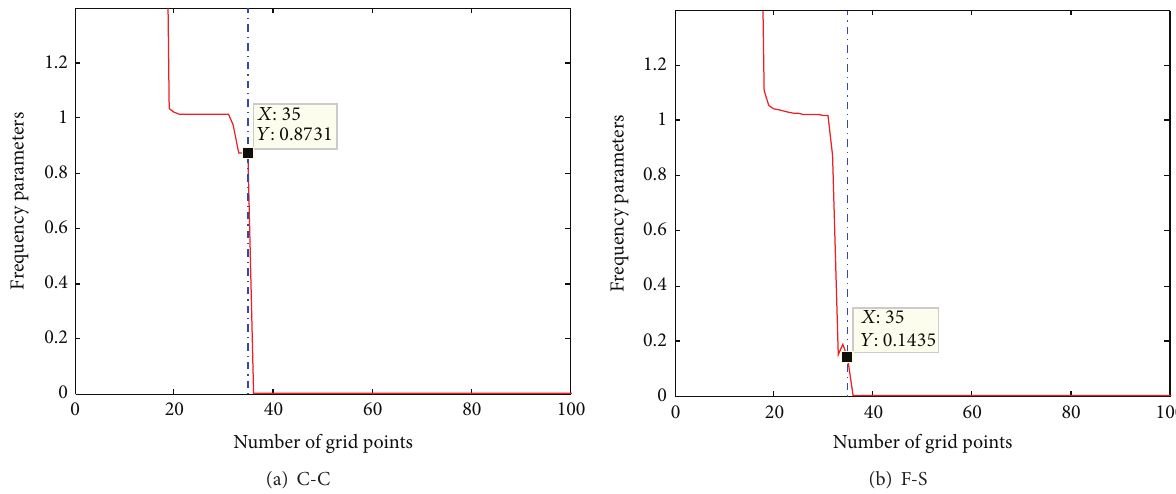
Figure 6: Natural frequency parameters derived by different numbers of grid points when 𝑀 = 30 ((a) C-C, (b) F-S).